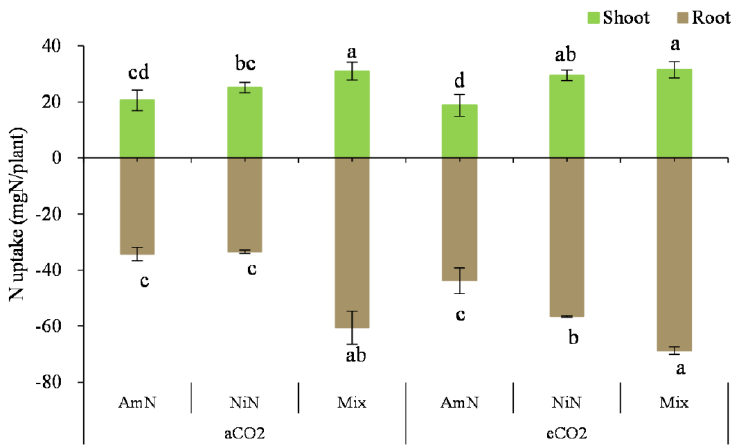
Figure 6. The N uptake of wheat seedlings. Note: (1) AmN denotes Ammonium N, NiN denotes Nitrate N, Mix denotes Mixed N; (2) TC means total C concentration, TN means total N concentration; (3) aCO 2 denotes the ambient atmospheric CO 2 concentration at 390 µmol/mol; eCO 2 denotes the enriched atmospheric CO 2 concentration at 690 µmol/mol; (4) Different letters mean significant differences at p < 0.05 level for each indice; (5) error bars are standard deviation; (6) above- and belowground LSD are separate analyses. Table 9. Two-factor ANOVA analyses for N uptake in wheat seedlings. Wheat Wheat Shoot N Uptake Root N